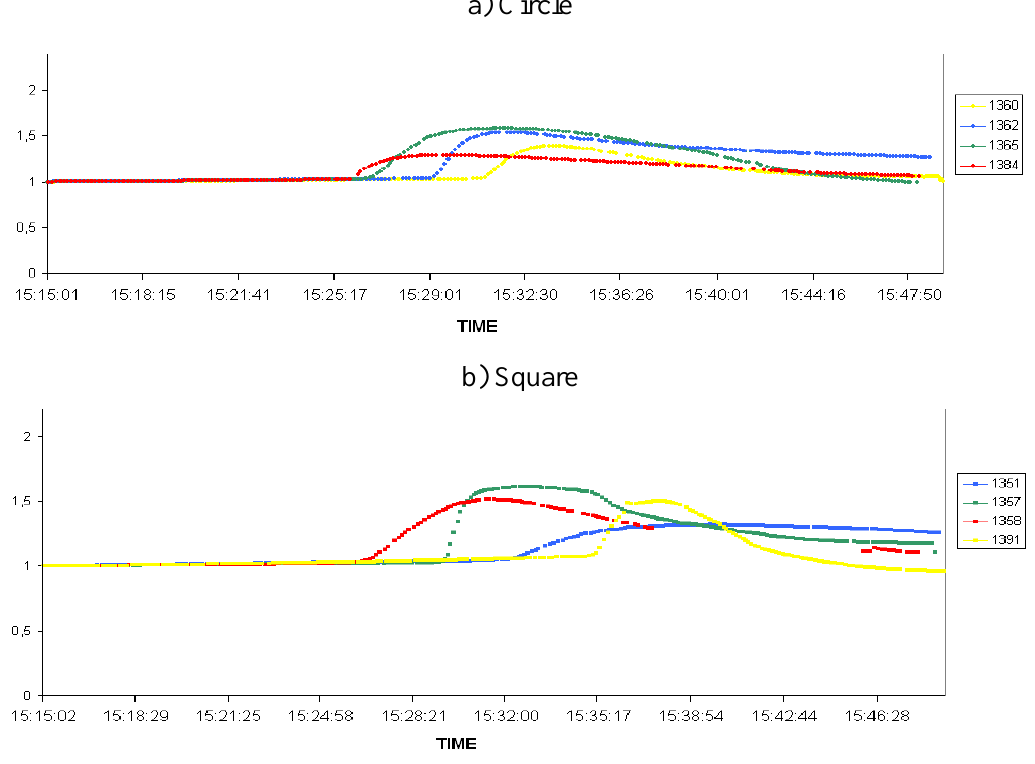
Figure 9. Humidity results of the 8 MICA2 3 rd GEN with a continuous data transmission.